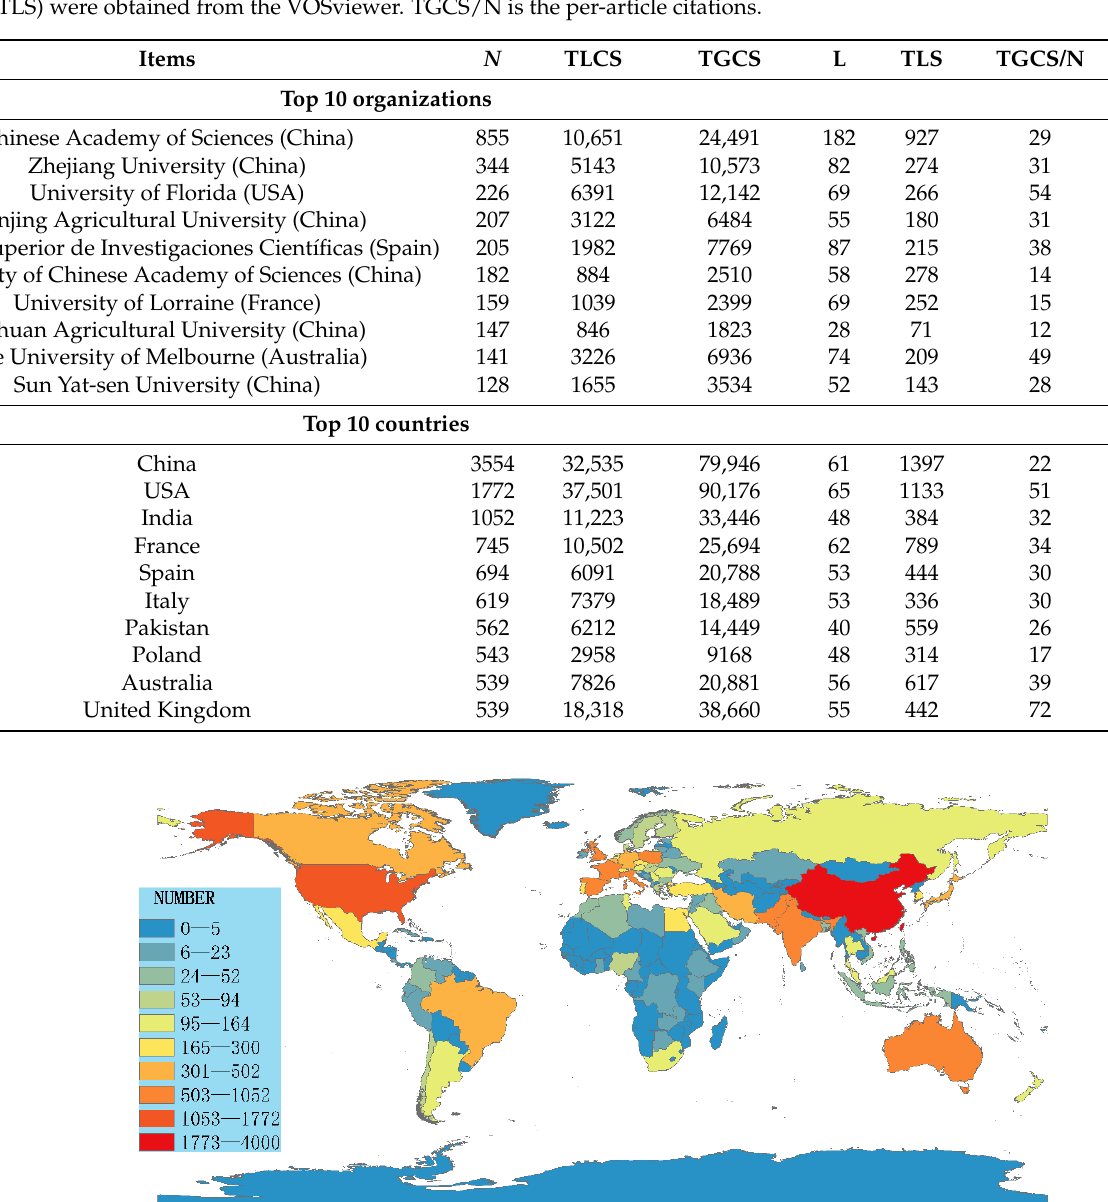
Figure 3. World map of publication distribution by country.